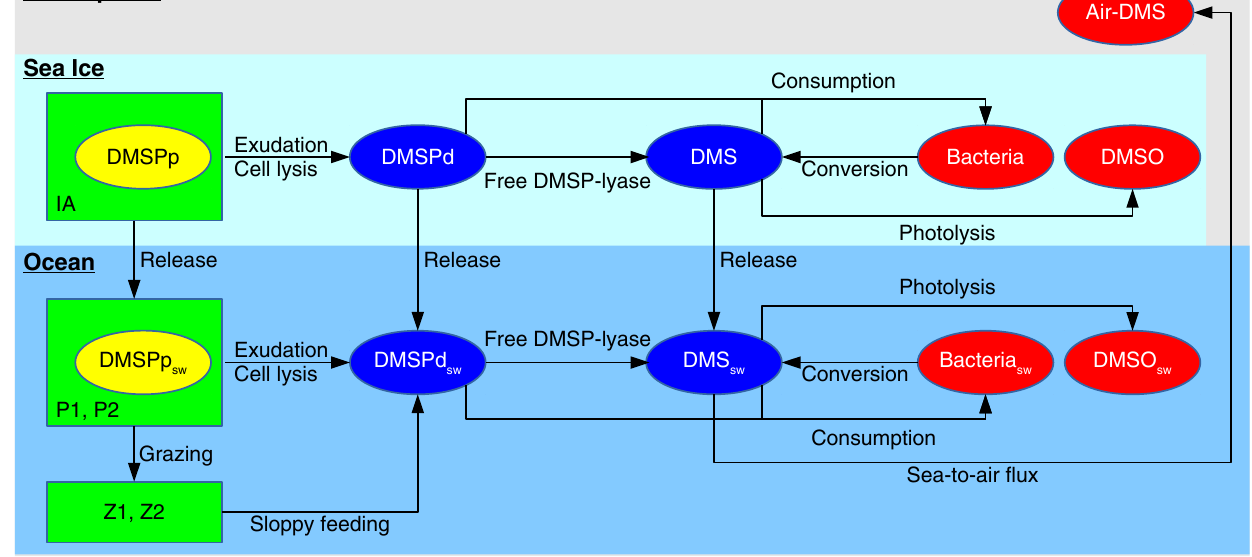
Figure 1. Schematic of the sea-ice and oceanic components of the sulfur cycle module. Variables in blue (yellow) are simulated prognostically (diagnostically), while the variables in red are not simulated but the relevant processes are parameterized. Variables in green are simulated prognostically by the ecosystem model. Arrows represent the physical and biogeochemical fluxes parameterized in the